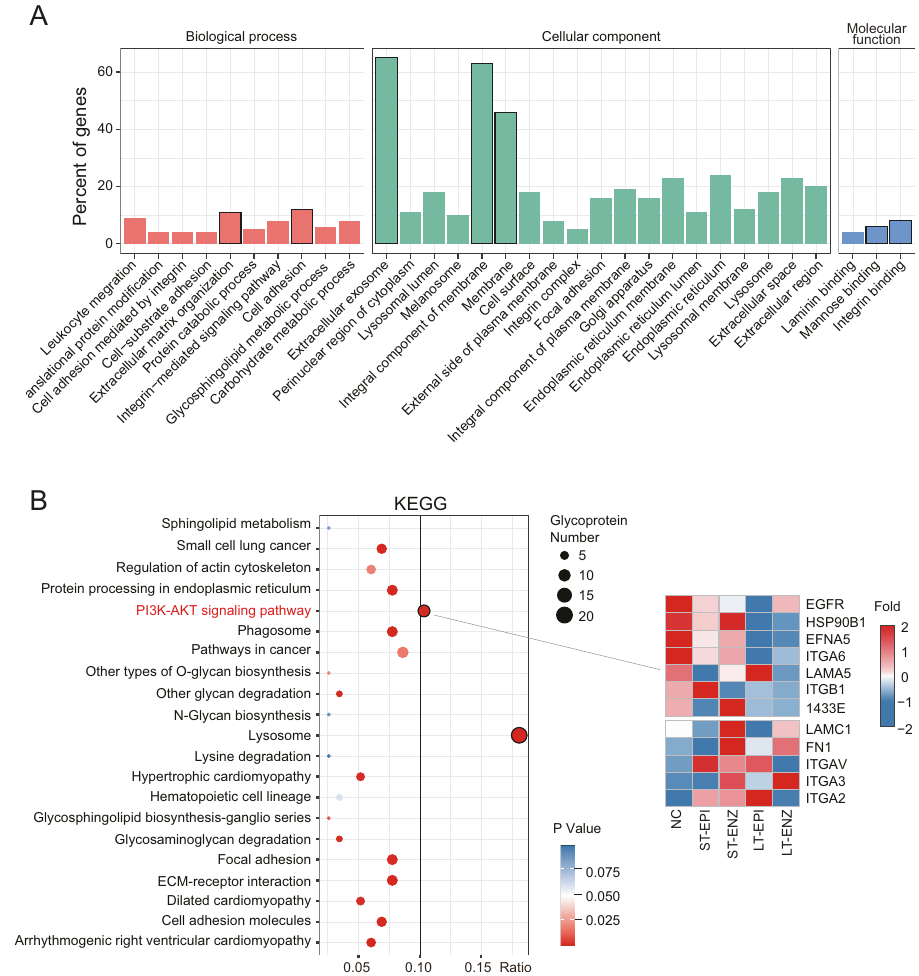
Fig. 4 PI3K-AKT pathway is enriched in the proteoglycomics dataset. A Statistical distribution chart of differentially expressed glycoproteins under each GO category (2 nd Level). The X -axis label is divided into three parts: biological process, cellular component, and molecular function. B KEGG pathway enrichment bubble plot of differentially expressed glycoproteins (left panel). The size and color of the bubbles re fl ect the glycoprotein counts and p value, respectively. Heatmap of the PI3K-AKT pathway-related glycoprotein expression (right panel).